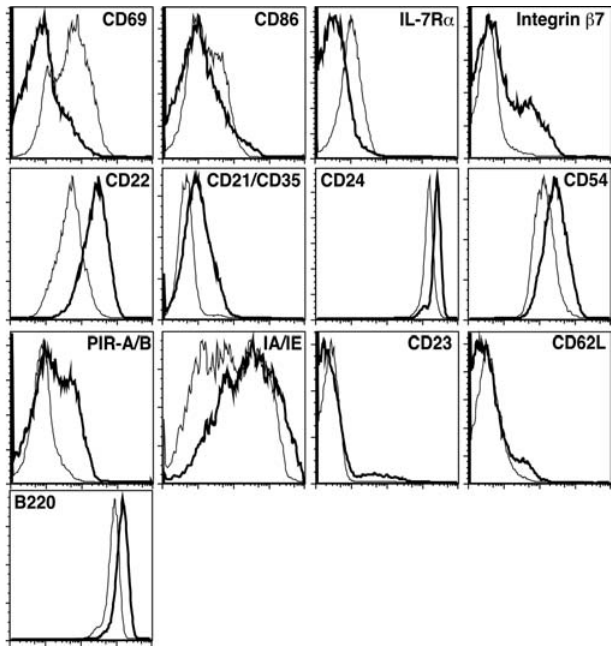
Figure 5. Protein Expression Confirms Reversal of Development in Immature B Cells Losing Surface IgM B1-8f/3-83 j control and B1-8f/3-83 j /Mx-Cre cell populations were harvested at the end of a 3- or 4-d culture with IFN ab (3,000 units/ml), stained with mAbs for cell surface proteins, and analyzed by flow cytometry. Shown are the expression levels of B220-gated Ctrl-M hi (thick line) and Cre-M lo (thin line) cells at the end of the culture period. Essentially identical results were observed when Cre-M hi and Cre-M lo cells were compared (data not shown). DOI: